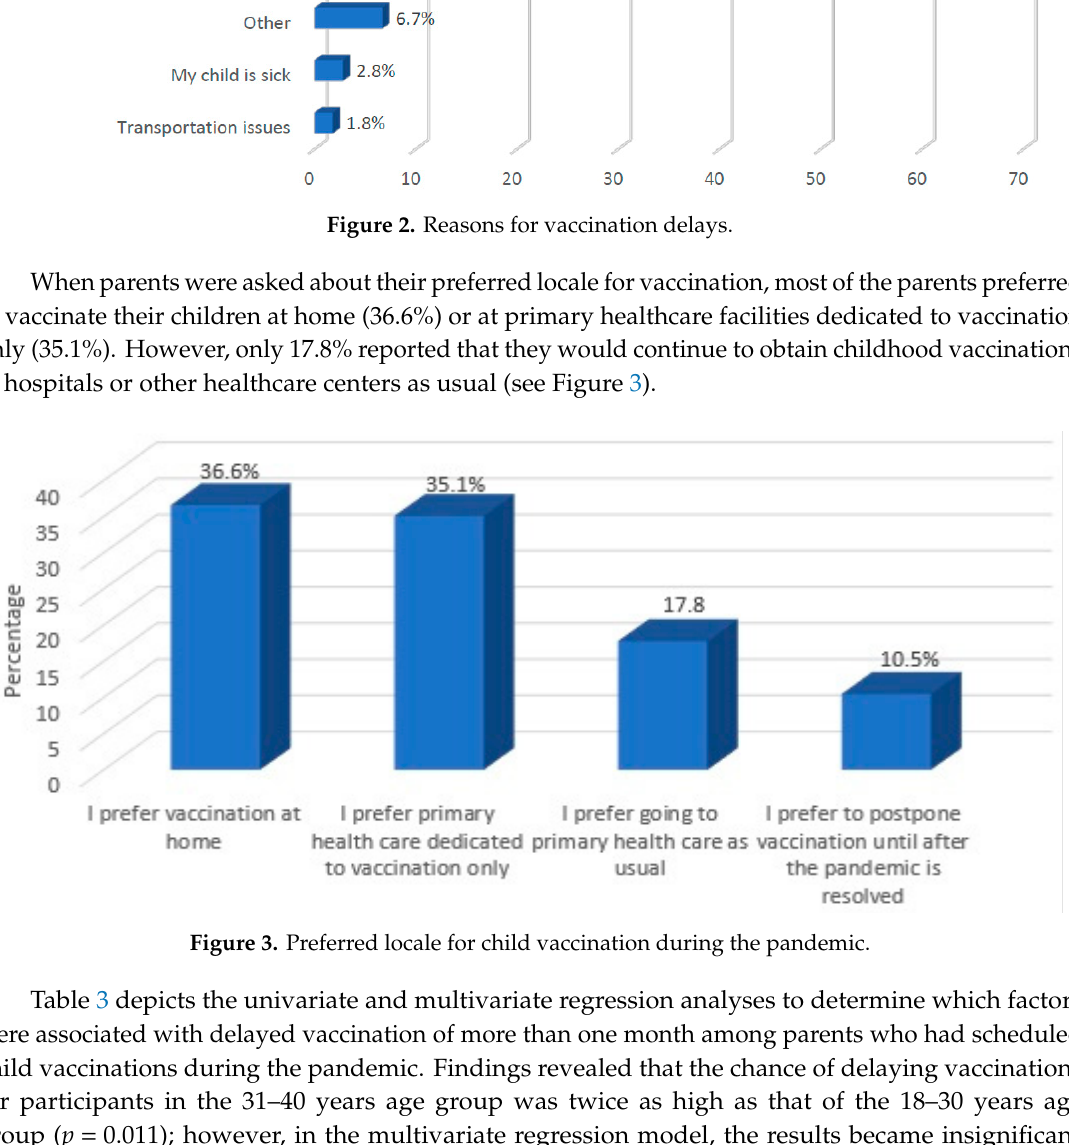
Figure 3. Preferred locale for child vaccination during the pandemic.